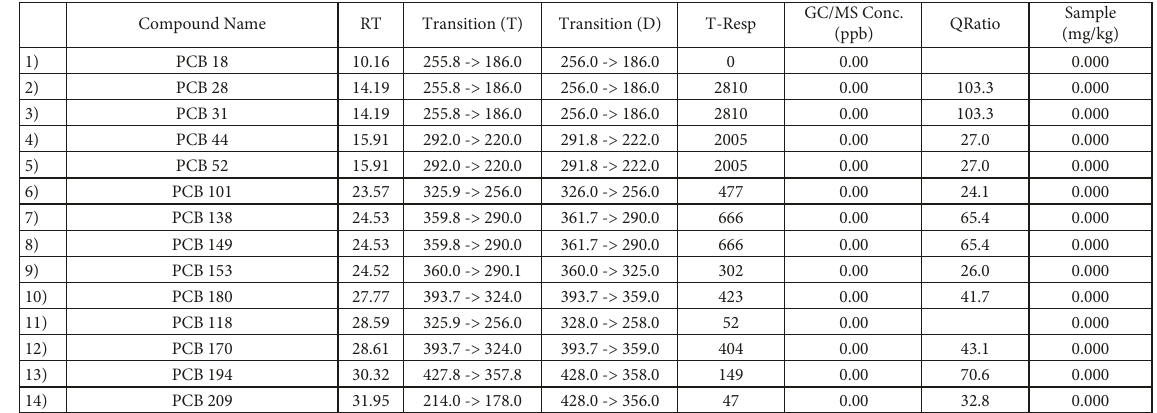
Figure 5: Laboratory blanks analysis results.